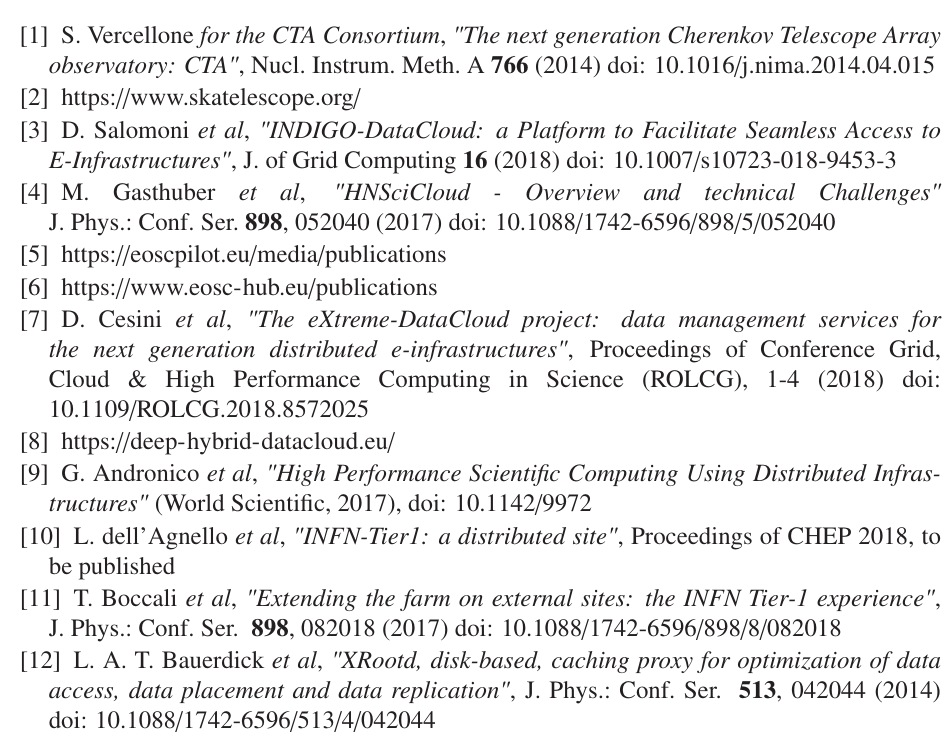
Figure 4. Possible Data Lake models for